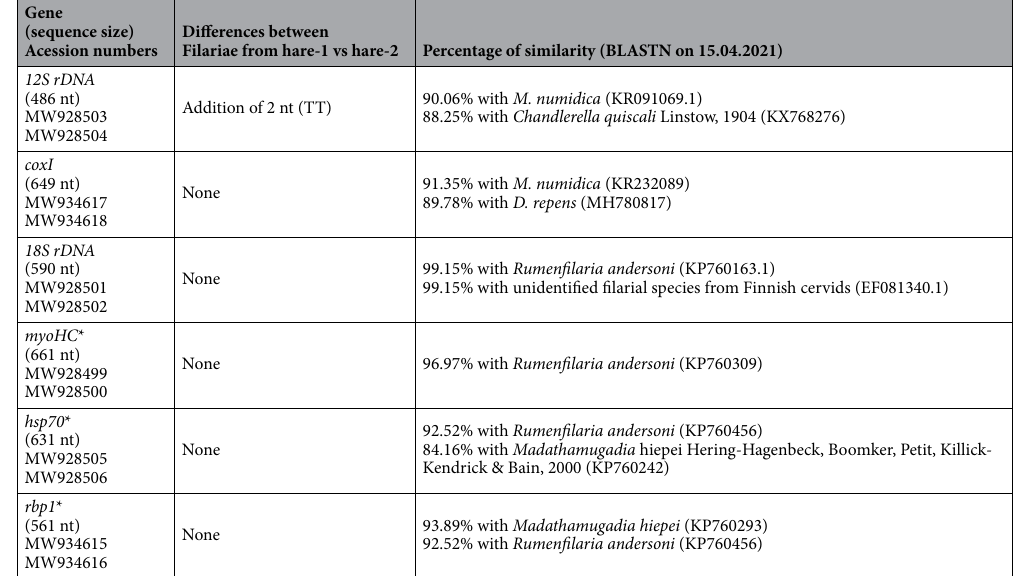
Table 2. Percentage of nucleotide similarity between M. iberica genes obtained from hare-1 and hare-2 and other filarioid genes sequences from public databases. * Micipsella sequences not available.